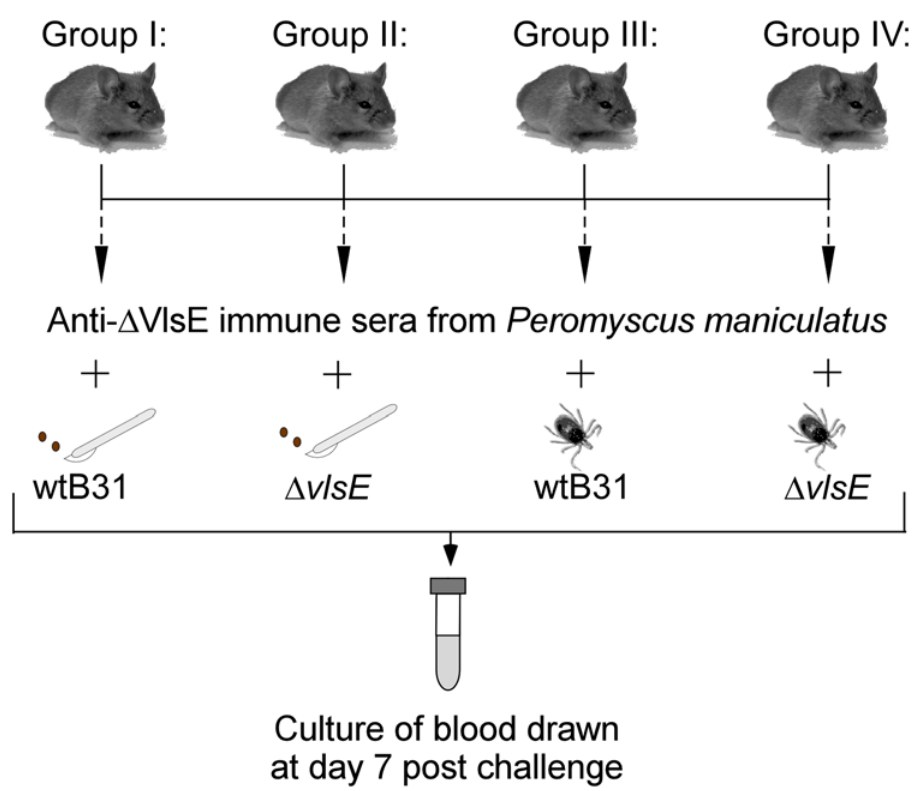
Fig 3. Design of passive transfer experiment to assess the ability of B . burgdorferi clones to evade antibodies. Preimmune and immune sera were originated, respectively, from na ï ve and Δ vlsE -infected P . maniculatus mice. Four groups of SCID mice (3 animals per group) were treated with immune sera from Δ vlsE -infected mice and challenged 18 hours later with host-adapted wtB31 (group I), host-adapted Δ vlsE (group II), nymph-transmitted wtB31 (group III) or nymph-transmitted Δ vlsE (group IV) clones. At day 7 post infection, blood was drawn from each mouse and cultured to assess the outcome of challenge. The control groups of mice confirmed the ability of host-adapted Δ vlsE or nymph-transmitted wtB31 and Δ vlsE clones to infect preimmune sera-treated or na ï ve SCID mice,